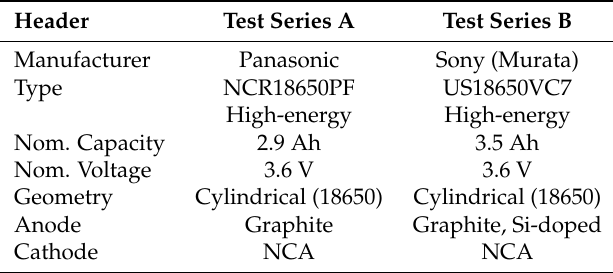
Table 6. Specifications of cell candidates for test series A and